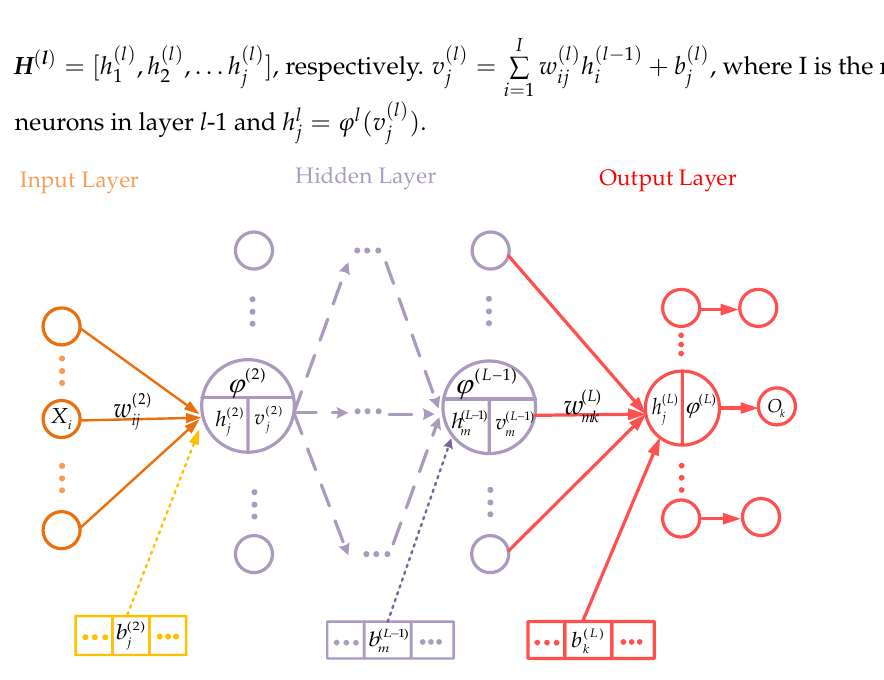
Figure 2. Topological structure of BPNN.